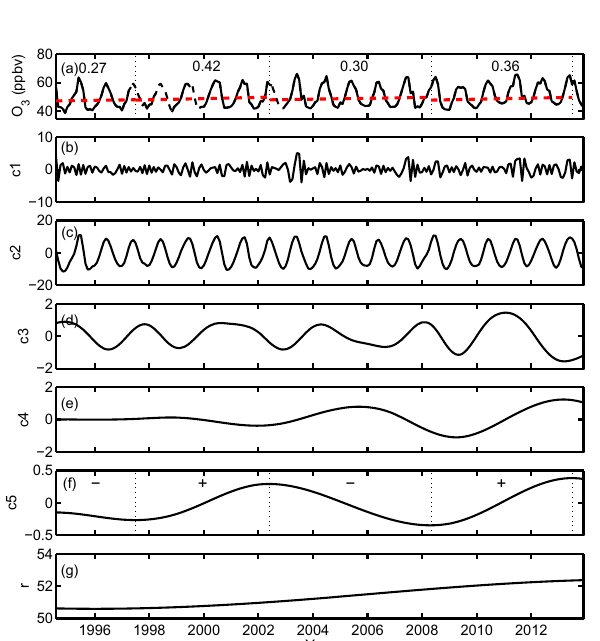
Figure 6. The interpolated monthly average ozone mixing ratio at WLG from 1994 to 2013 (the interpolated data given in dashed lines, a ) and its intrinsic mode functions c1–c5 ( b – f , from the lowest to the highest-order IMF) and its residue, r (g) . The time segments in (a) were determined by the slope of the c5. The red slashed lines are the Theil–Sen trends and the numbers are the Theil–Sen trend estimates (in ppbvyear − 1 ) .